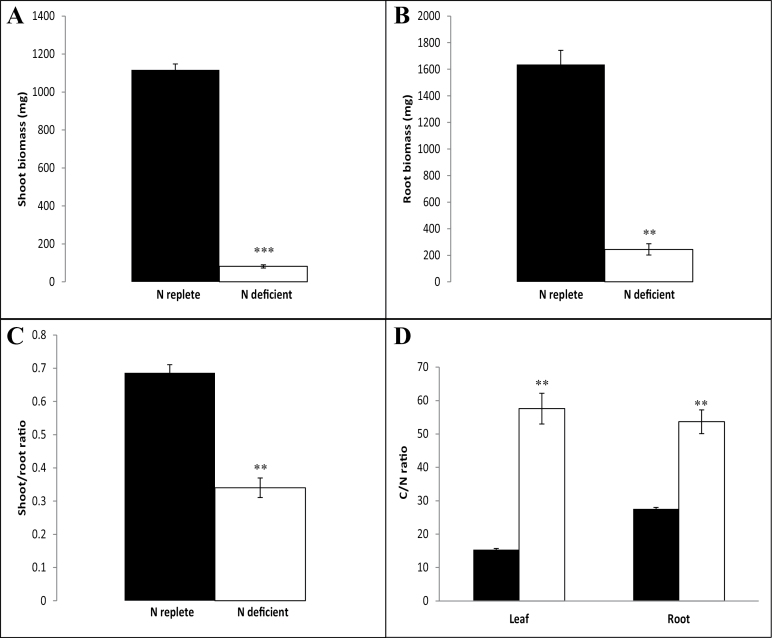
Impact of N availability on plant biomass and C/N ratio. Plants were grown under N repletion or N deficiency as described in the text and harvested 7 d after transfer to variable N conditions. Shoot (A) and root (B) biomass were used to estimate shoot/root ratio (C) and C and N contents were estimated in each as described in the text to calculate C/N ratio (D). Columns represent mean values and bars standard error (n=5). In (D) black columns represent plants grown under N repletion and white columns plants grown under N deficiency. Significant differences were estimated using the student’s t-test; ** P<0.01, *** P<0.001.